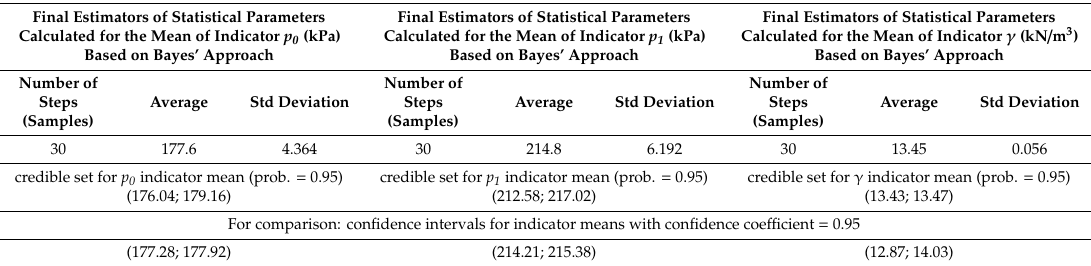
Table 4. Final results for indicators p 0 , p 1 , and γ in the peat, gyttja, and organic mud layers.